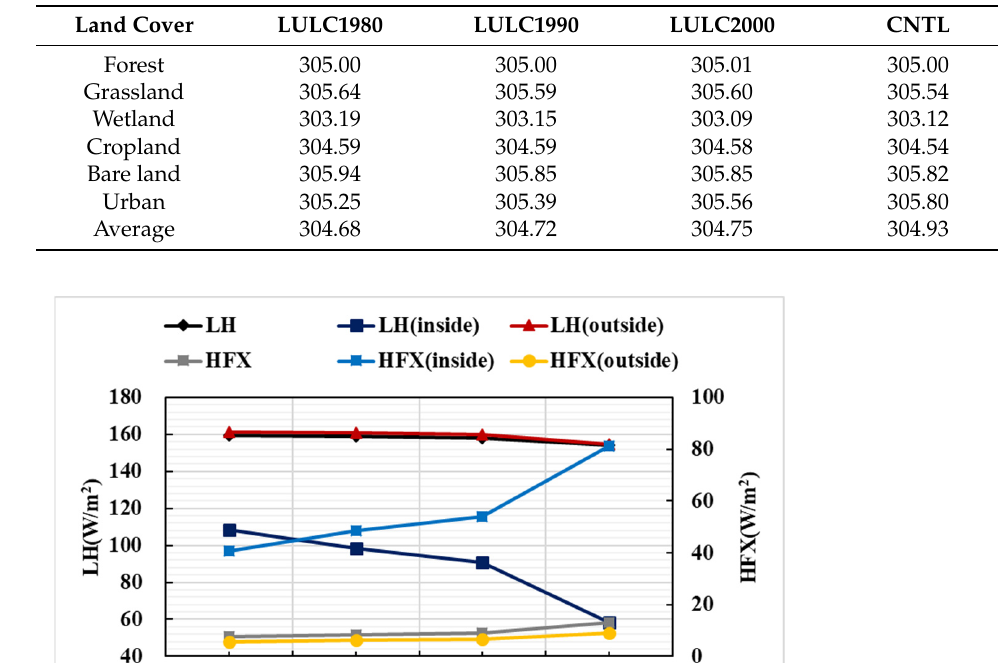
Figure 10. The fraction of each LULC type in different periods within the third ring road ( a ) and the fraction of each land cover type outside the third ring road but inside the administrative boundary of Wuhan ( b ). Table 5. The averaged LST for each LULC type in different simulations (Unit: K).